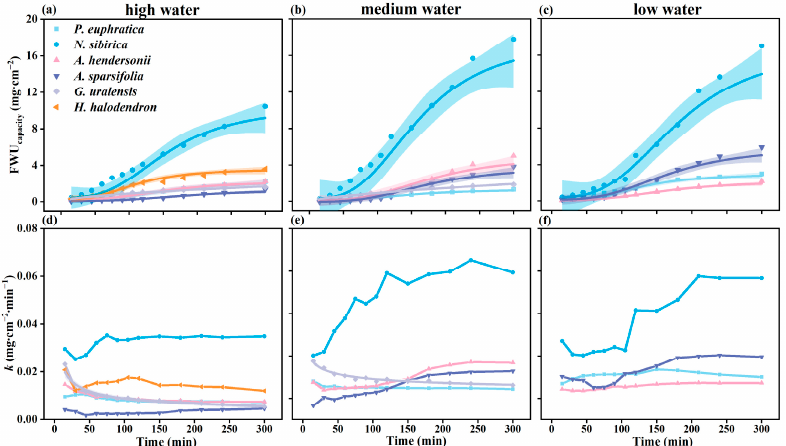
Figure 3. The variation in foliar water uptake accumulation per unit area (FWU capacity ) and foliar water uptake rate ( k ) over time. ( a – c ) FWU capacity of six plants under high water, medium water, and low water gradients over time; ( d – f ) k of six plants under high water, medium water, and low water gradients over time. Colored regions show 95% confidence intervals for the mean predicted value estimated using logistic and exponential models, and the parameters fit using each model are presented in Table S2 (N = 4).